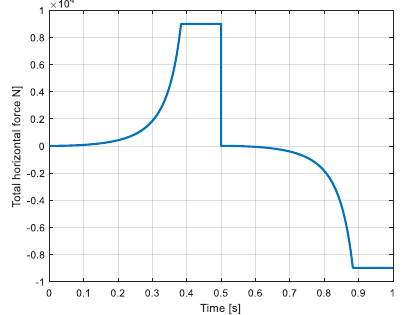
Figure 9. Force developed by the left piston (N).